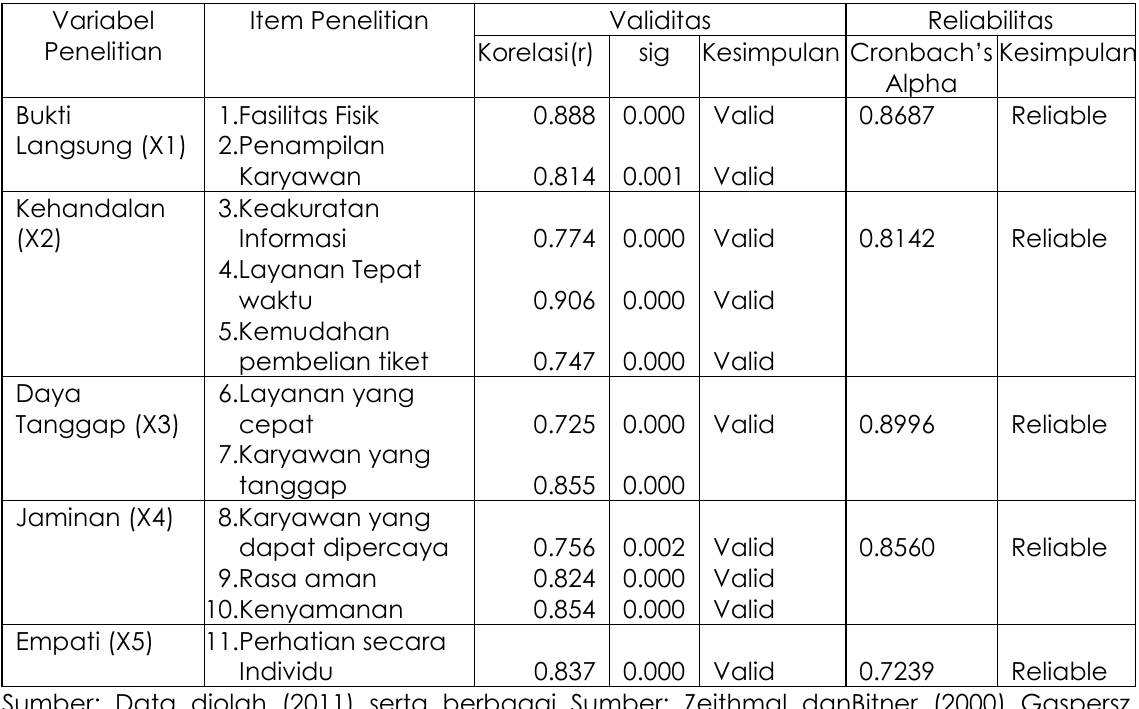
Table 1. Hasil Analisis Uji Validitas dan Reliabilitas Instrumen Penelitian